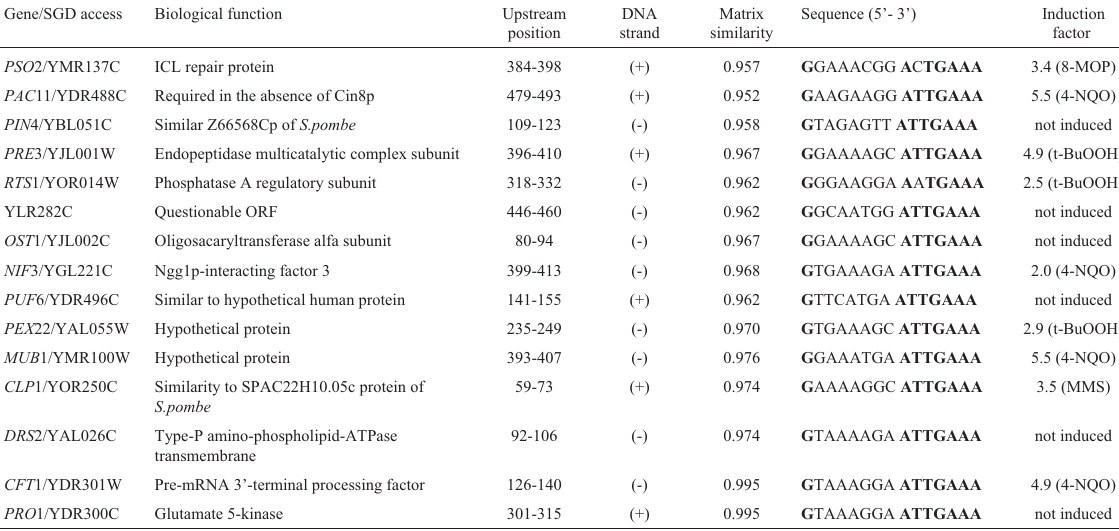
a Descriptions, symbols and abbreviations are as described in Table 1.